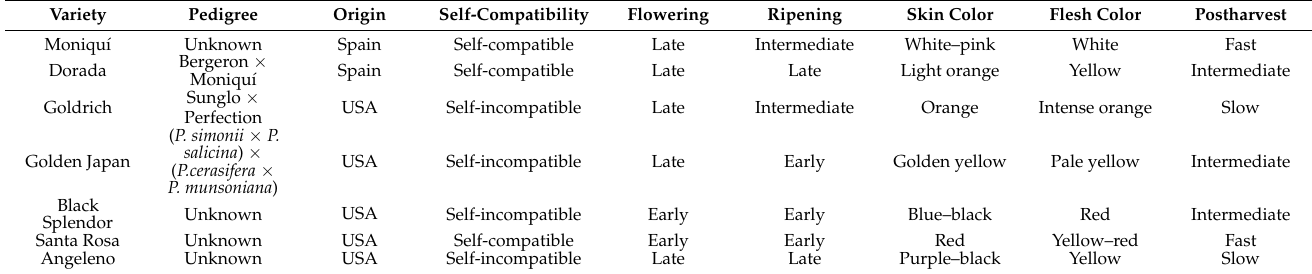
Table 1. Description of apricot and Japanese plum cultivars assayed, including the pedigree, origin, and main agronomical